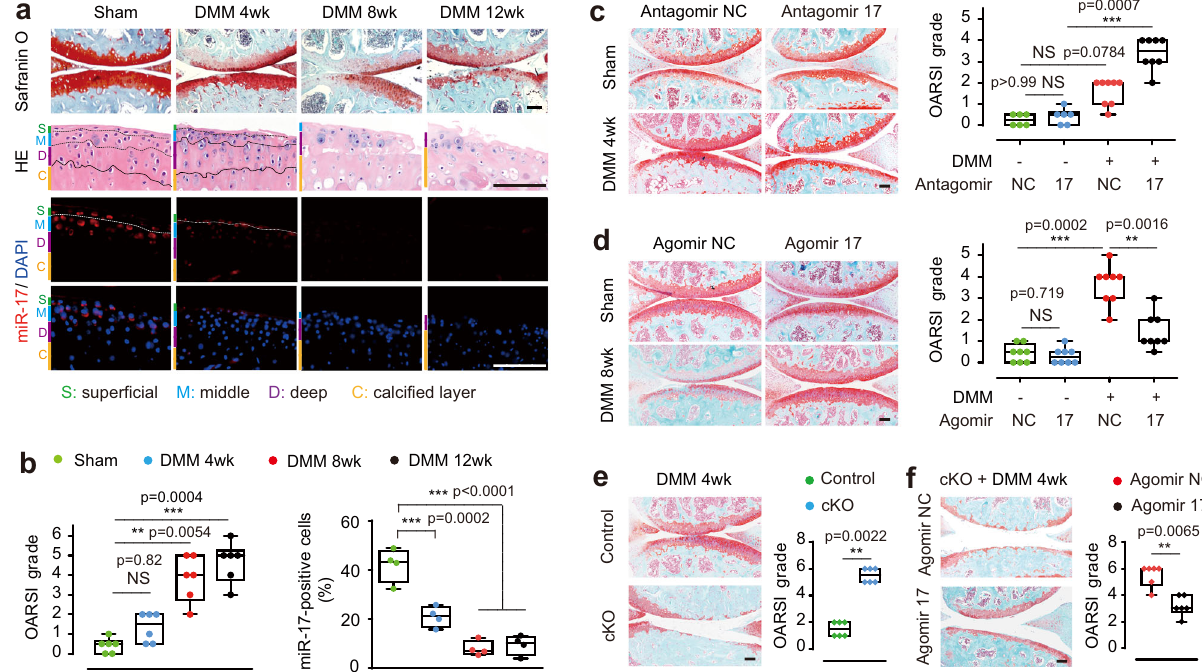
Fig. 1 MiR-17 de fi ciency exacerbated cartilage destruction in DMM-induced OA. a Representative images from the safranin O/fast green and H&E staining, as well as FISH analysis of miR-17 in knee joint sections at 4, 8, or 12 weeks after sham operation or DMM surgery. Male mice underwent surgeries at the age of 10-week old. Cartilage structure was visualized by safranin O/fast green. H&E staining showed layers of articular cartilage. The color bars at the left side of pictures were used to demonstrate the different layers. The blue staining by DAPI showed nuclei to visualize the cellular location of miR-17. The images are representative of three independent experiments. b OARSI scores ( n = 6 mice at each timepoint) and percentage of miR-17- positive cells in FISH staining ( n = 4 mice at each timepoint) from mice at indicated timepoints after operation. OARSI scores were used to quantify the cartilage destruction from safranin O staining sections. c Safranin O staining and scoring of OARSI grade in mice subjected to sham operation or DMM surgery and weekly intra-articular injection of antagomir-NC or antagomir-17 (3 nmol) for three times, starting from 1 week after surgery. n = 6 mice (sham + antagomir-NC, sham + antagomir-17); n = 8 mice (DMM + antagomir-NC, DMM + antagomir-17). d Representative images of safranin O/fast green staining of joint sections and OARSI scores. Agomir-NC or agomir-17 (1.5 nmol) was injected into knee joints 4 weeks after sham operation or DMM surgery. The injections were performed weekly for 4 times. n = 8 mice per group. e Representative images of safranin O/fast green staining and OARSI grade from miR-17~92 cKO mice and their control littermates (miR-17~92 fl / fl ) at 4 weeks after DMM surgery. n = 6 mice per group. The cKO mice and their controls were injected with tamoxifen at the age of 7-week old and performed surgeries at the age of 8-week old. f Representative images of safranin O/ fast green staining and OARSI grade in miR-17~92 cKO mice subjected to DMM surgery and intra-articular injection of agomir-NC, or agomir-17 (2 nmol). The injections were preformed weekly for 3 times beginning at 1 week after surgery. n = 6 mice per group. Data are presented as boxplots. Boxplots: center line, median; box limits, 25 to 75th percentiles; whiskers, min to max. NS not signi fi cant, * P < 0.05, ** P < 0.01, and *** P < 0.001. One-way ANOVA (nonparametric) with Dunn ’ s multiple comparisons test for OARSI grade in ( b , c ); Mann – Whitney U test (two sided) for ( d , e , f ); one-way ANOVA with Bonferroni ’ s test for percentage of positive cells in ( b ). All scale bars, 100 μ m. All the analyses were sourced from tibial cartilage. Source data are